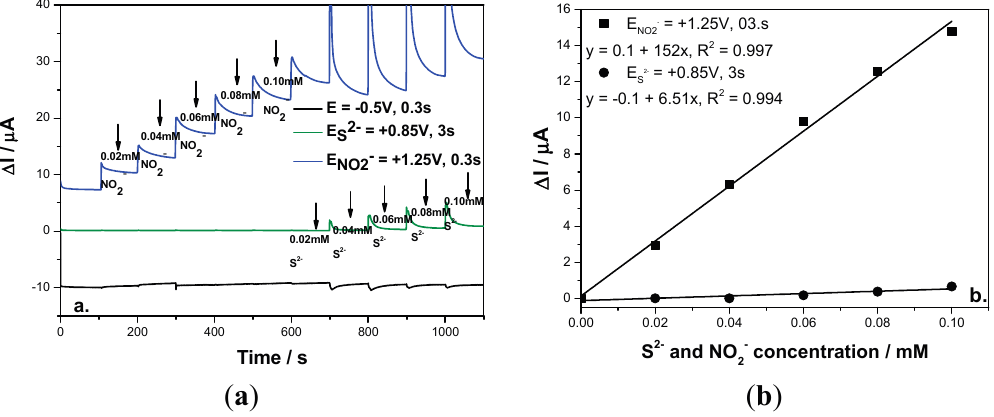
Figure 6. ( a ) Multiple-pulsed amperograms recorded at a BDD electrode in 0.1 M Na 2 SO 4 supporting electrolyte and adding consecutively and continuously each of 0.02 mM nitrite and respective, sulfide, recorded at E 1 = − 0.5 V/SCE, E 2 = +0.85 V/SCE, E 3 = +1.25 V/SCE; ( b ) Calibration plot of the current vs . anion concentration recorded at: E 2 = +0.85 V/SCE vs . sulfide concentration and E 3 = +1.3 V/SCE vs . nitrite